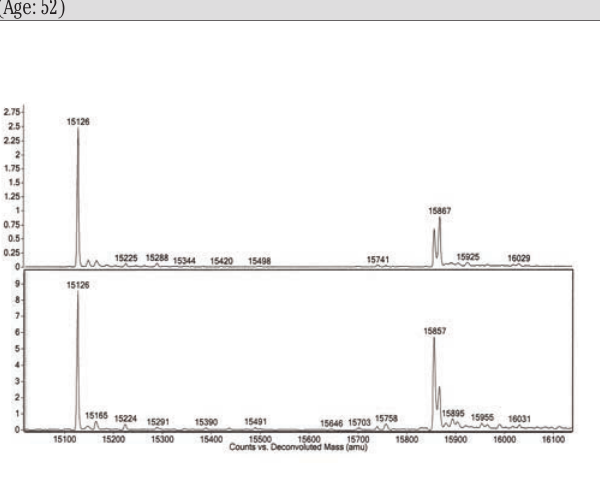
Figure 3. Tryptic peptide map showing a decrease in intensity at 952.5 m/z and a new signal at 942.5 m/z confirming a 5Pro Ser β →